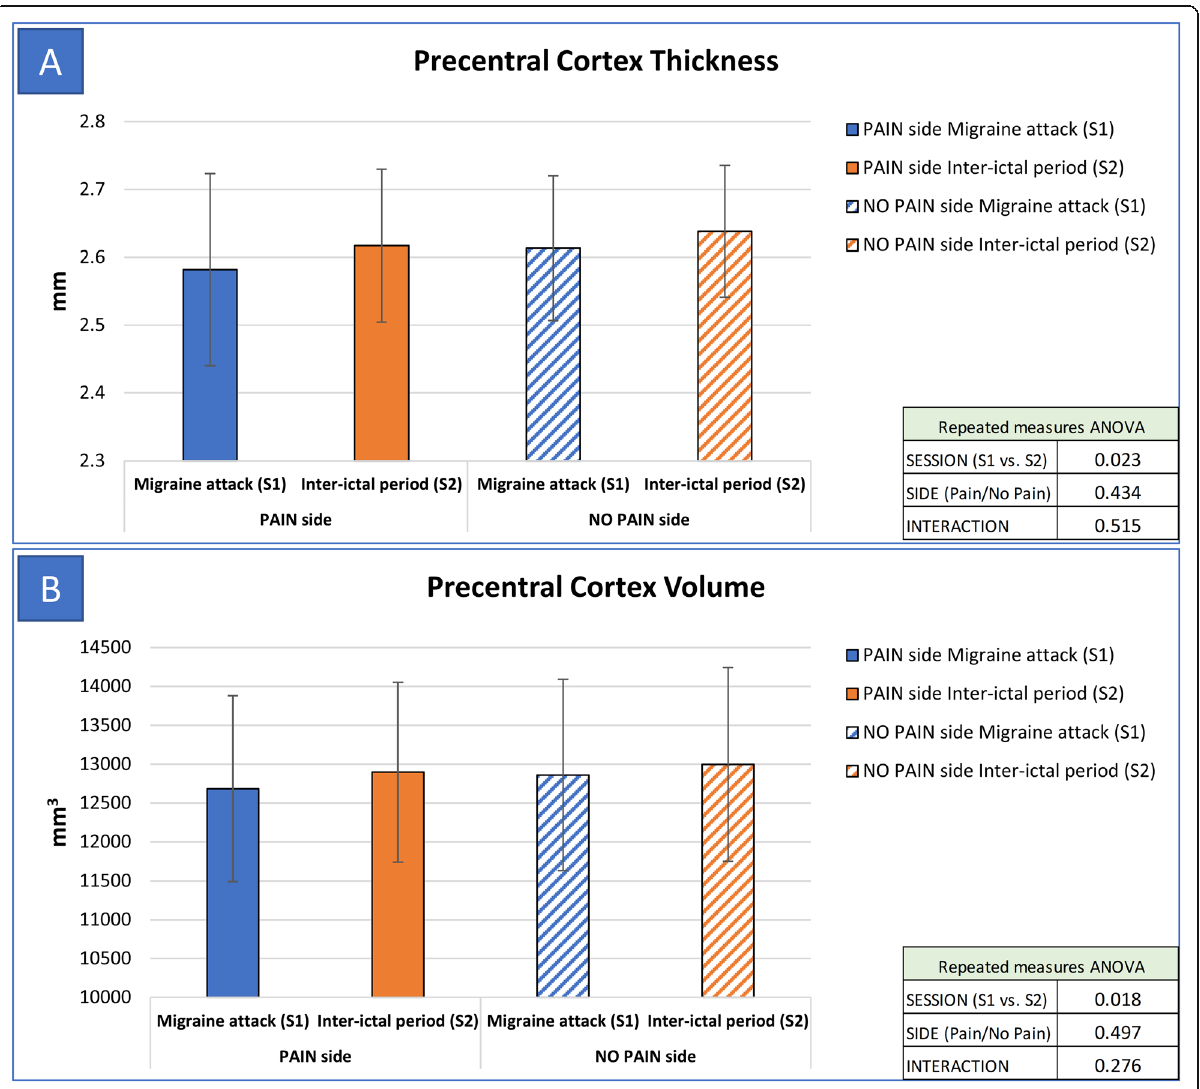
Fig. 1 Comparison of precentral cortex thickness and volume between S1 and S2 scans. Legend: S1: MRI scan performed during spontaneous migraine attack; S2: MRI scan performed during inter-ictal period; PAIN side refers to the side of spontaneous migraine attack recorded at T1. Panel A: thickness of precentral cortex was significantly lower during S1 (factor SESSION: p = 0.023), without significant association with the pain side (factor SIDE: p = 0.434, interaction SESSIONxSIDE: p = 0.515). Panel B: volume of precentral cortex was significantly lower during S1 (factor SESSION: p = 0.018), without significant association with the pain side (factor SIDE: p = 0.497, interaction SESSIONxSIDE: p =